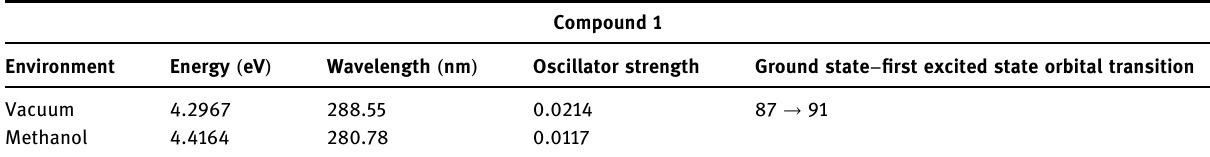
Table 5: First excited states of the voriconazole 1 computed using LR TDDFT approach in vacuum or in methanol; PBE1PBE/6 - 311 ++ G ( 2d,3p ) //PBE1PBE/6 - 31G ( d,p ) level of